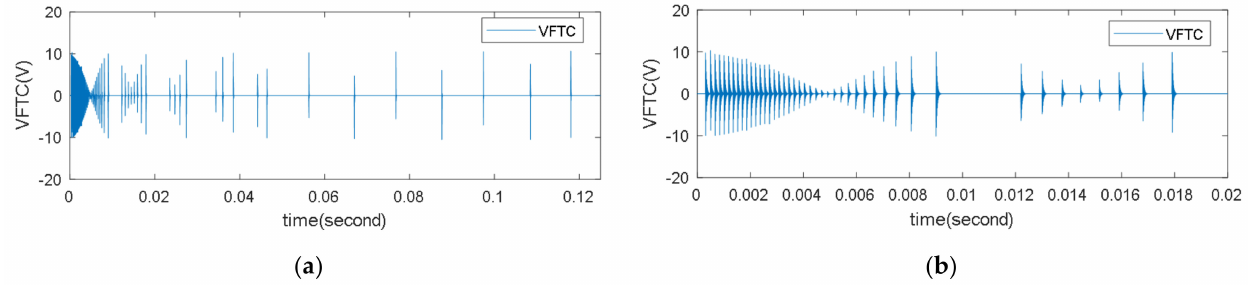
Figure 12. VFTC waveforms in the whole process at the secondary port of the Rogowski coil (S. No2). ( a ) VFTC waveforms; ( b ) the expansion of VFTC